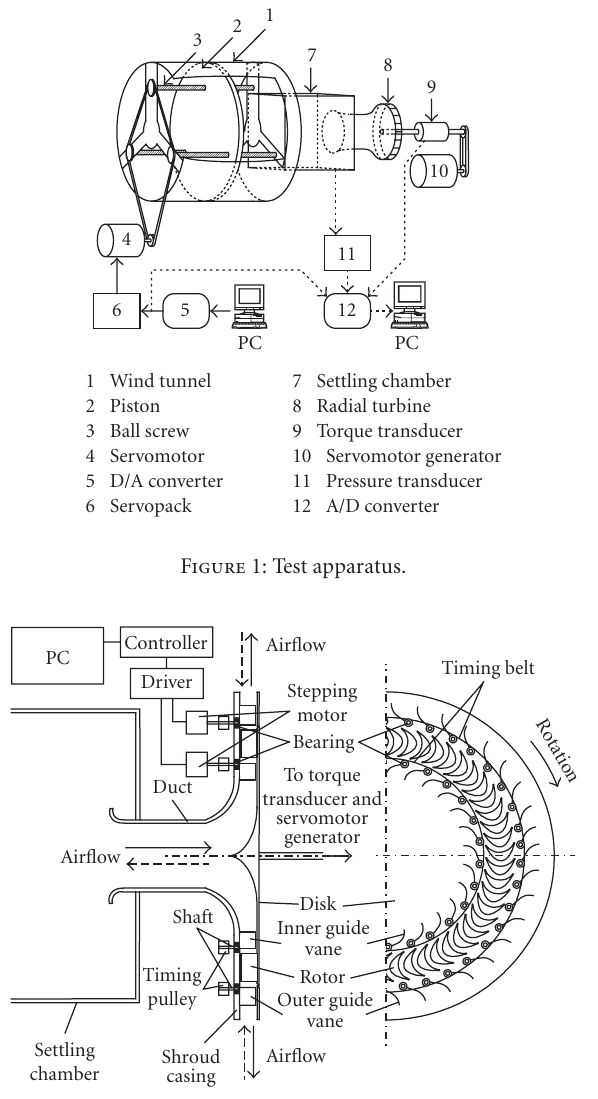
from the rig to the atmosphere), is measured by Pitot tube survey. The radial flow velocity v R at mean radius r R in the turbine is calculated from Q = A R v R , where A R is the flow passage area at mean radius ( = 2 πr R h ). In a typical test, for a particular turbine geometry, the volumetric flow rate Q , pressure di ff erence between settling chamber and atmo- sphere Δ p , turbine torque T o , and turbine angular velocity ω are all recorded. Thereby, data for one flow coe ffi cient φ defined in (3) are obtained. Data for a range of flow coe ffi - cients are collected by varying flow rate or turbine angular velocity. Tests were performed with turbine shaft angular ve- locities ω up to 68.1 rad/s and flow rates Q up to 0.275 m 3 /s. The Reynolds number based on the blade chord was approx- imately 3 × 10 4 at conditions corresponding to the peak e ffi - ciency of the turbine. The measurement uncertainty in e ffi - ciency is about ± 1%.